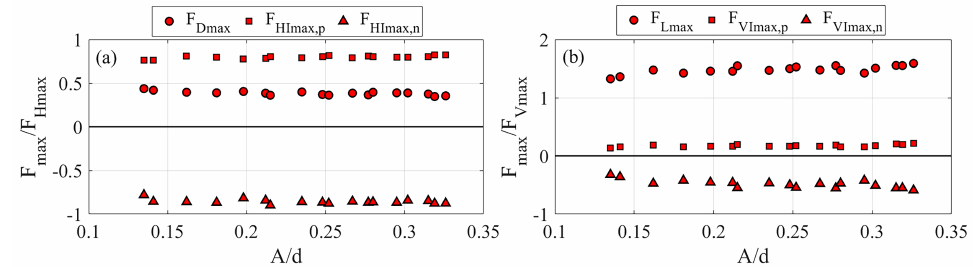
Figure 13. ( a ) Maximum Morison force components vs. A/d: positive drag F Dmax , positive horizontal inertia F HImax , p and negative horizontal inertia F HImax , n ; ( b ) maximum transverse force components vs. A/d: positive lift F Lmax , positive vertical inertia F VImax , p and negative vertical inertia F VImax , n